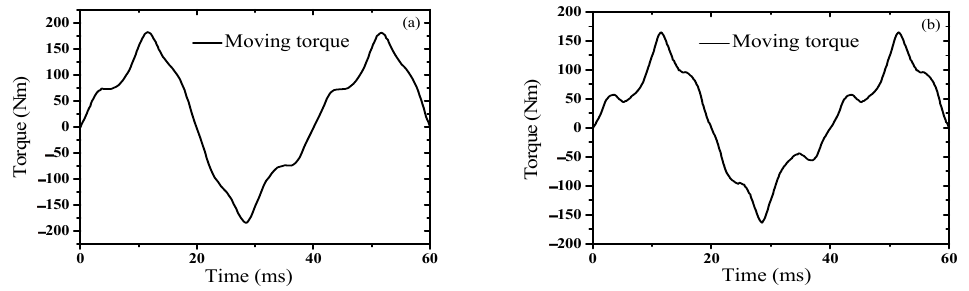
Figure 9. Simulated torque of model 1 ( a ) and model 2 ( b ) over time.